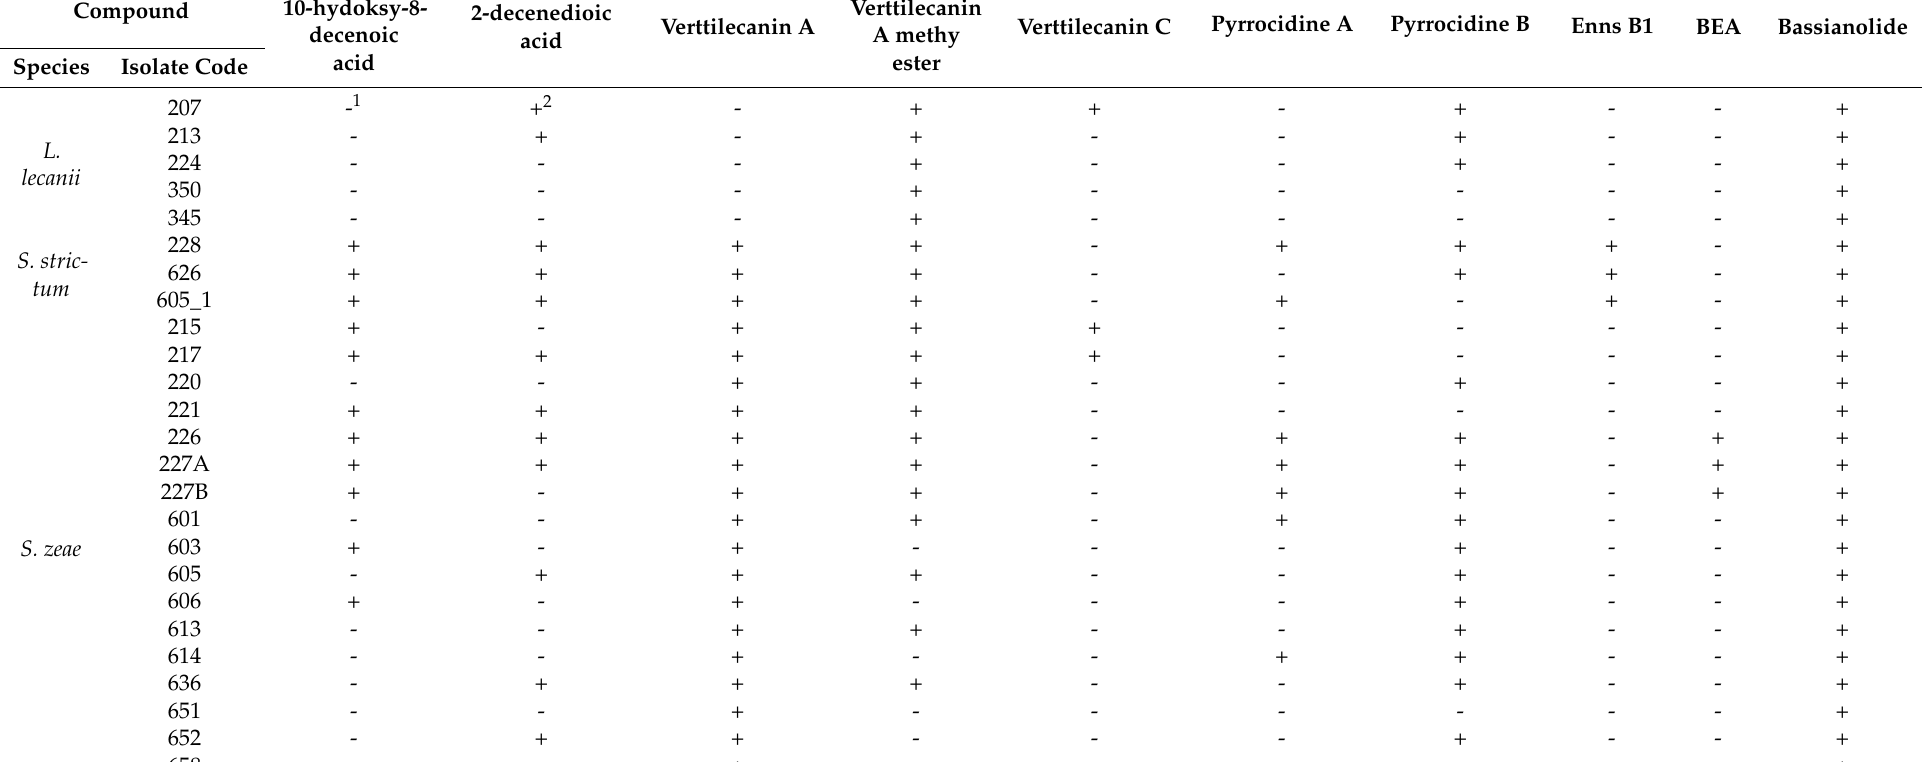
Table 2. The profiles of selected metabolites formed by L. lecanii , S. zeae and S. strictum isolates grown on a rice solid